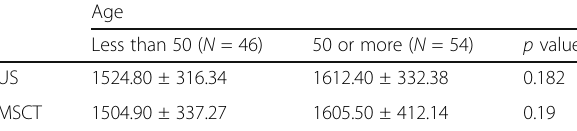
Table 2 Average liver volume by US and CT as regards age